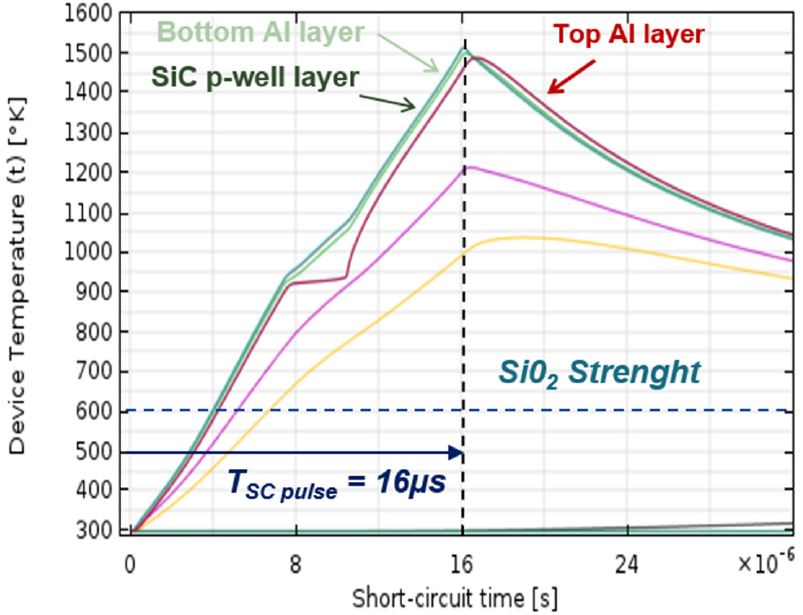
Figure 14. Estimated temperature of the main chip layers under Comsol for the DUT#8 at V DS = 600 V DS = 600 V, V Drv = − 5 V/10 V and T case = 25 ◦ C at T SC = 16 µ V, V Drv = − 5 V/10 V and T case = 25 °C at T SC = 16 µs.